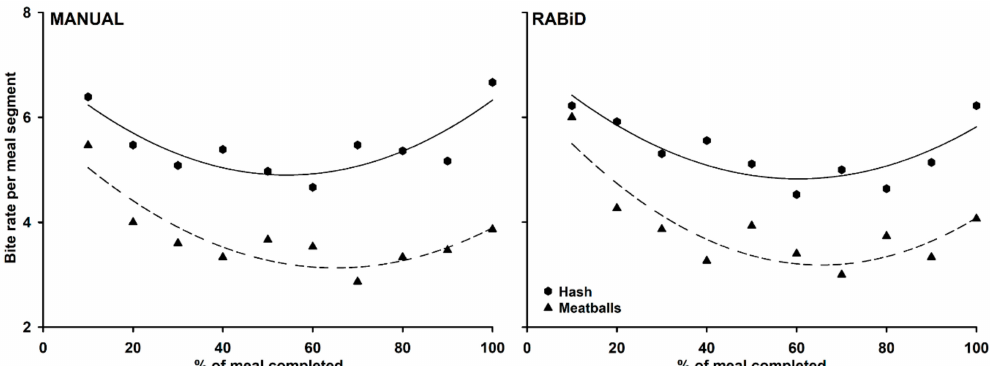
Figure 7. Changes in bite rates during hash and meatball meals, as revealed by manual annotations and RABiD analysis outcomes. Bite rates per meal segment are calculated as bites during 10% of meal duration (bites /